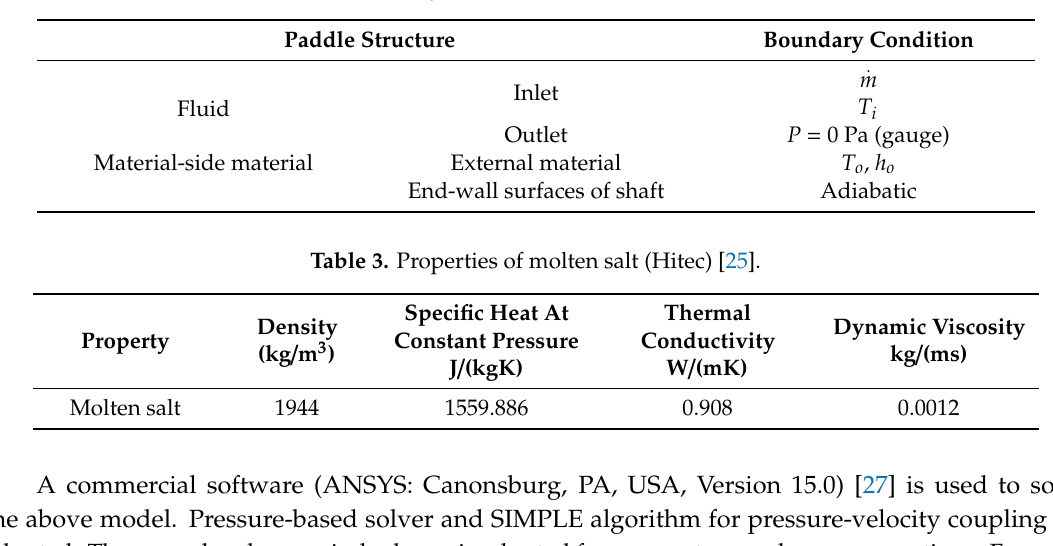
Table 2. Boundary conditions for flow and heat transfer.